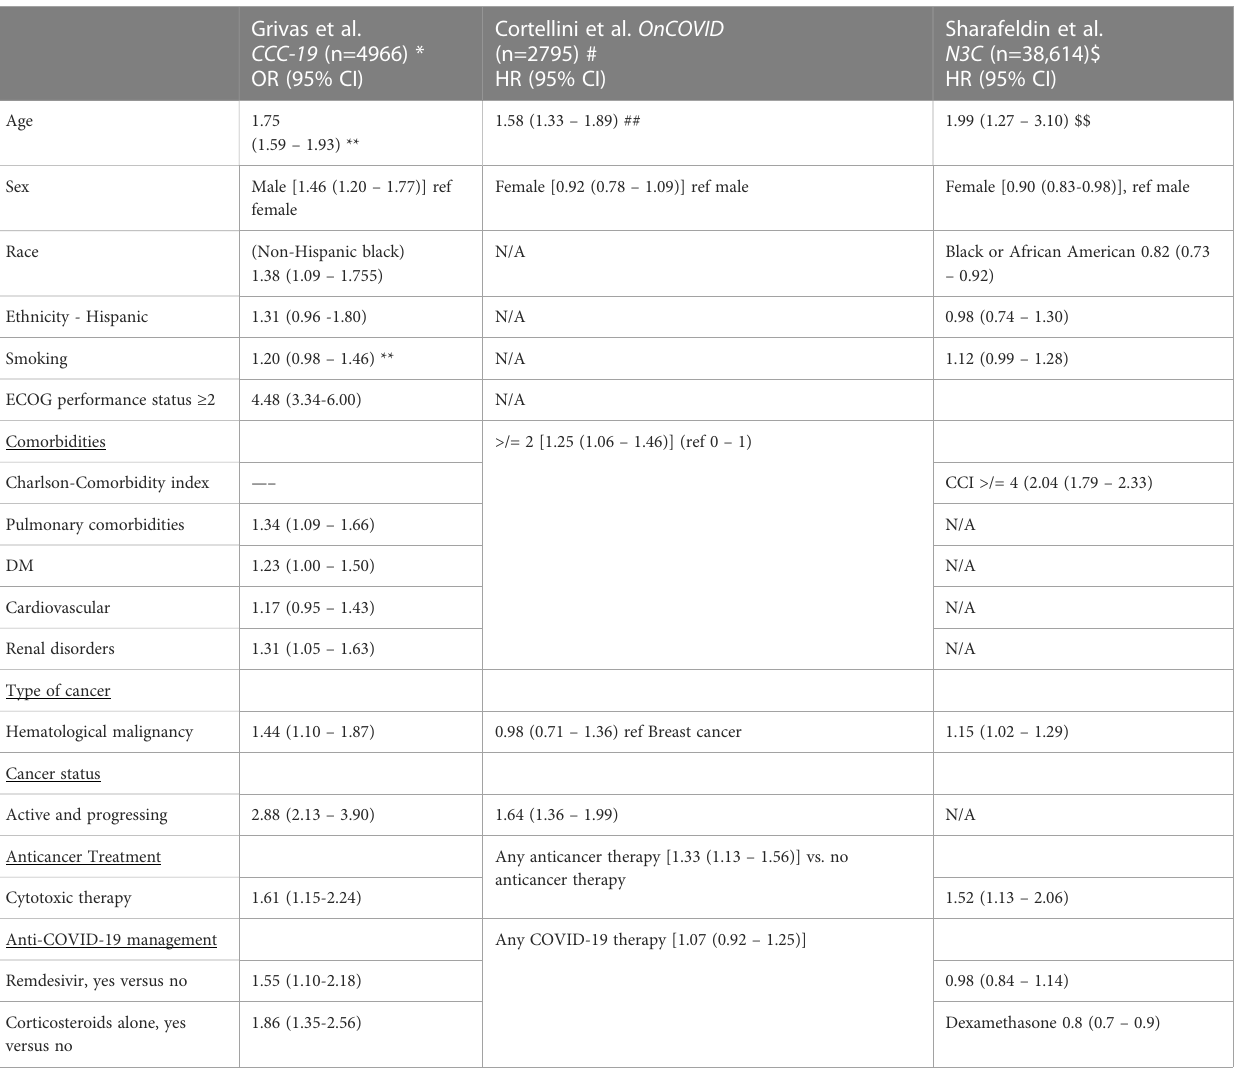
TABLE 1 Comparison of key risk factors in different observational